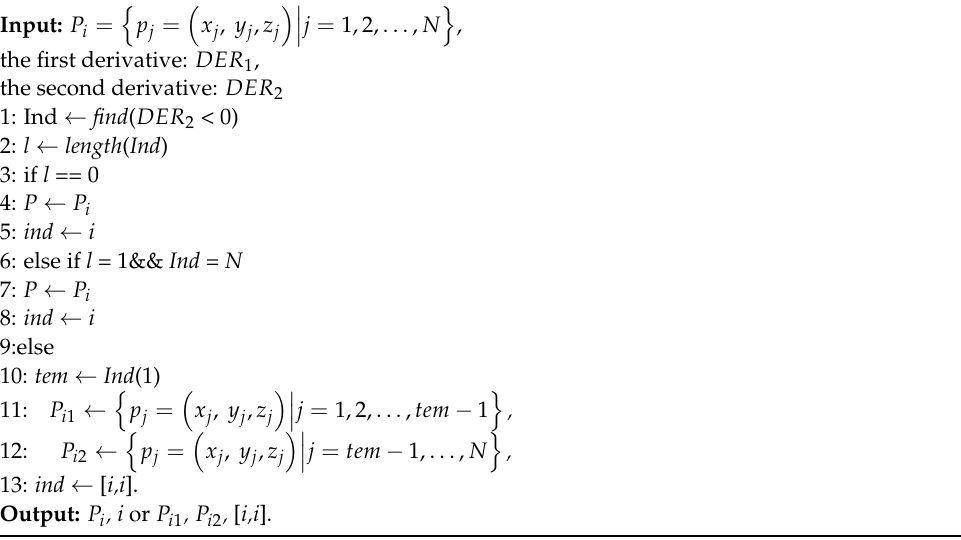
Algorithm 2: Spitting a neighborhood into two